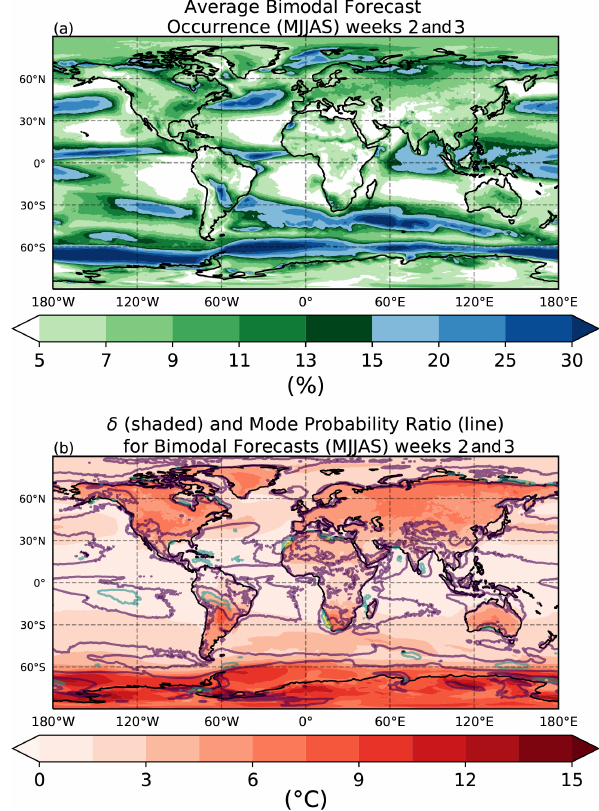
Figure 7. (a) The average occurrence of forecasts that are consid- ered bimodal for all Northern Hemisphere extended winter months (November, December, January, February, March) in the ECMWF dataset. (b) The accompanying average delta between the two modes (shaded) and the relative probability of the absolute max- imum compared to the relative minimum for forecasts that are bimodal (contour). Purple, blue, and yellow contours represent 2 times, 3 times, and 4 times as likely, respectively.